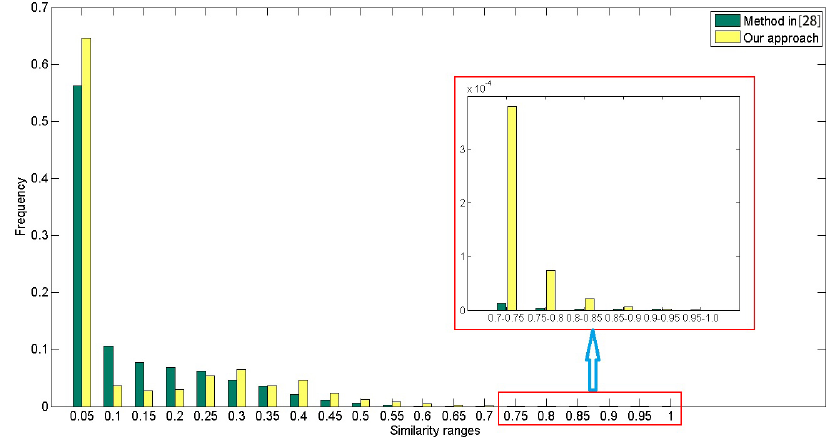
Figure 15. Comparison chart of the similarity histograms for reference scene